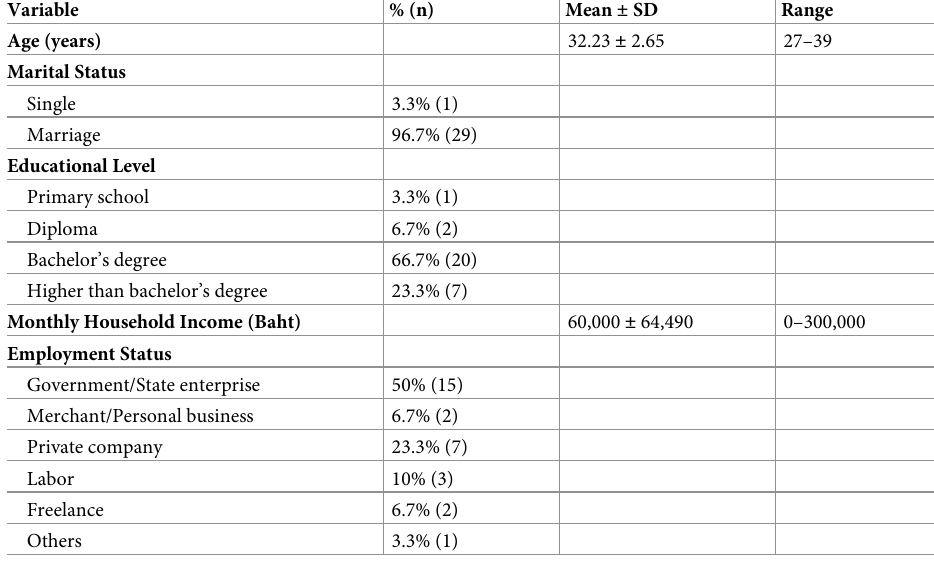
After the expert panel review, our team agreed on adjusting one statement in items 3–5. In